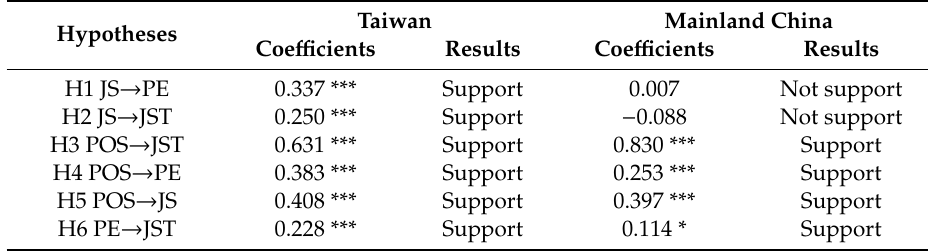
Table 6. Results of hypotheses